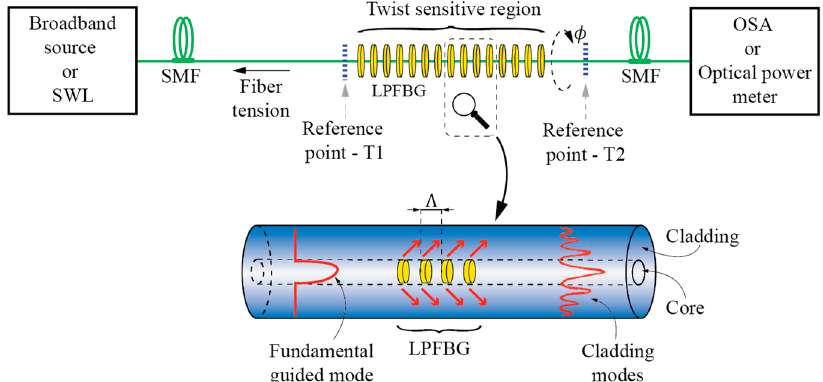
Figure 11. Typical LPFBG twist/torsion test setup.